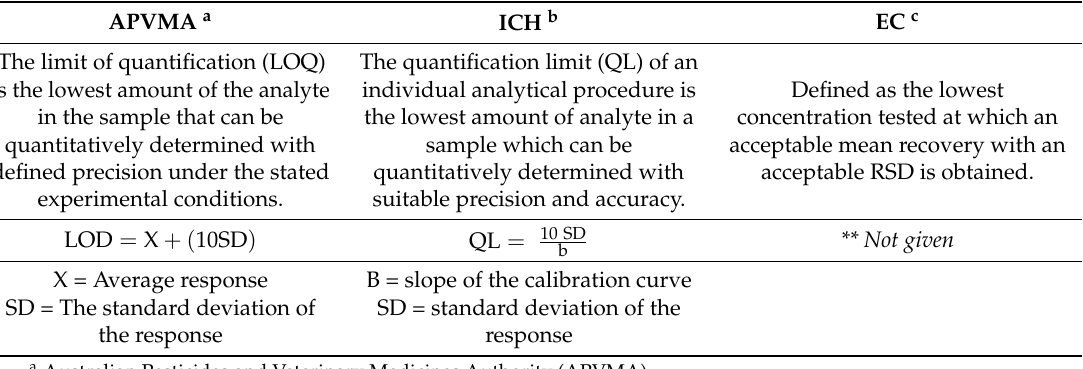
Table 4. Accepted methods for calculating the limit of quantification (LOQ) or quantification limit (QL). APVMA a ICH b EC c The quantification limit (QL) of an Defined as the lowest individual analytical procedure is concentration tested at which an the lowest amount of analyte in a acceptable mean recovery with an sample which can be acceptable RSD is obtained. quantitatively determined with suitable precision and accuracy.